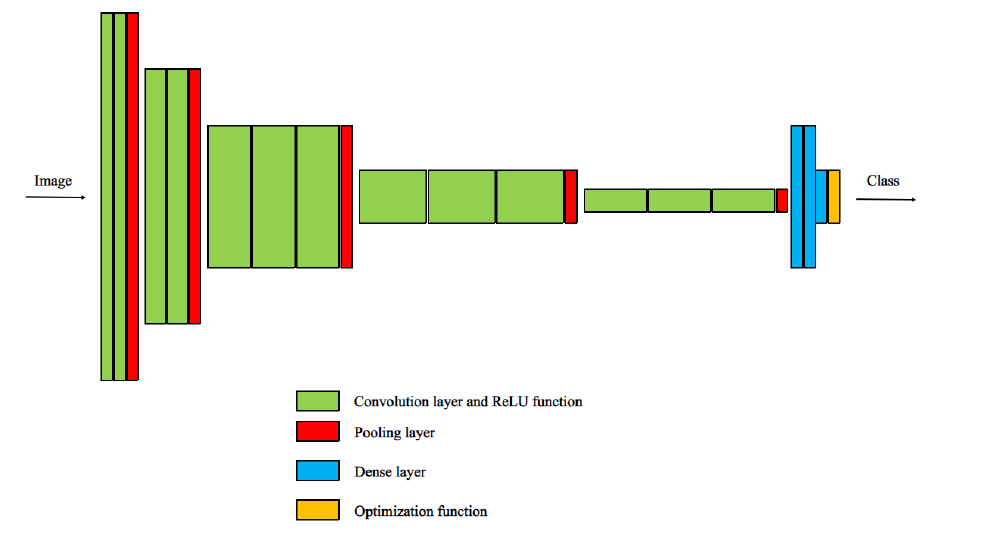
Figure 3. Architecture of the VGG network [5].